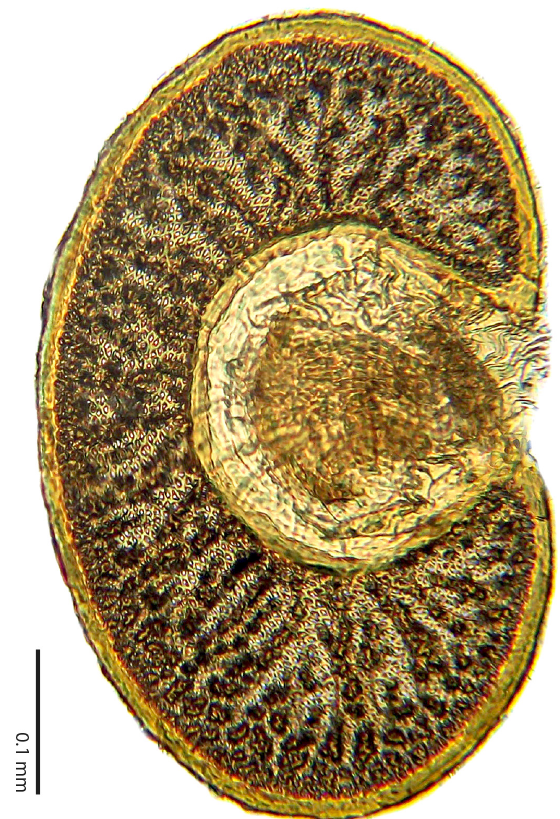
Figure 4. Stenocrates agricola , thoracic spiracle and detail of the spiracular